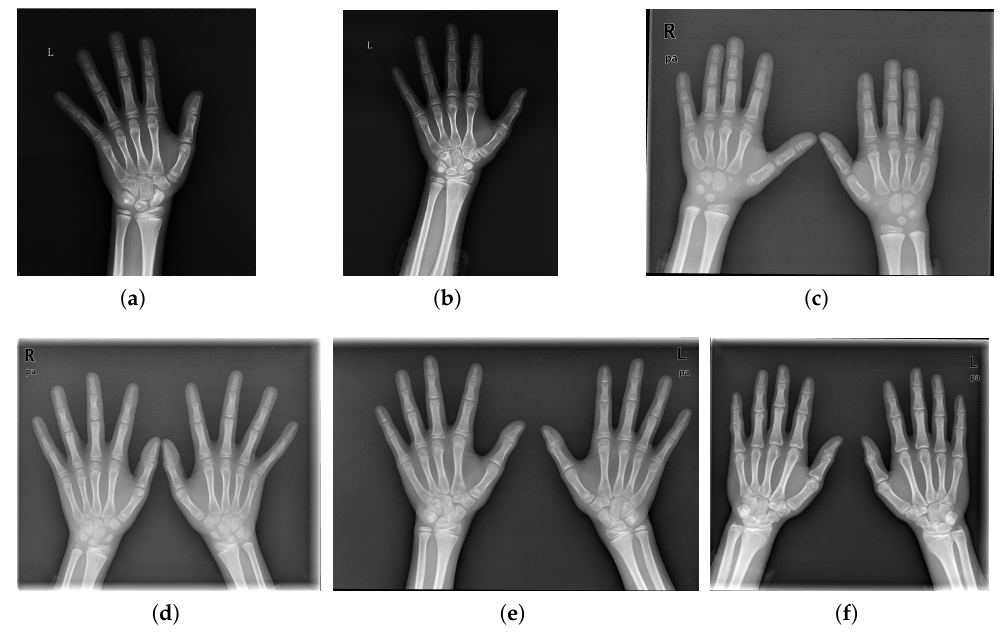
Figure 2. Examples of raw datasets. “L” marks the left hand position, “R” marks the right hand posi- tion; ( a ) 10-year-old; ( b ) 13.5-year-old; ( c ) 5-year-old; ( d ) 6-year-old; ( e ) 13-year-old; ( f )